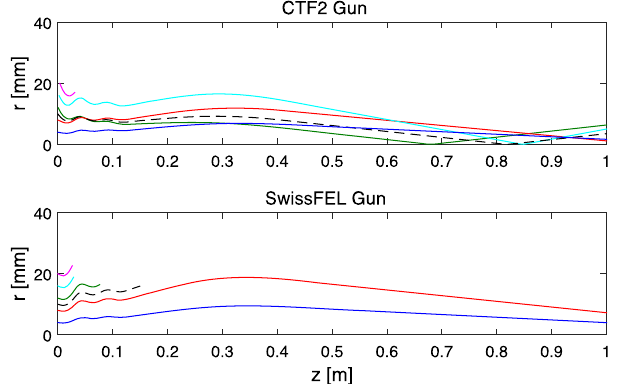
FIG. 6. Interferometric roughness measurement of cathode surface. Evaluated R a ¼ 5 . 2 nm.